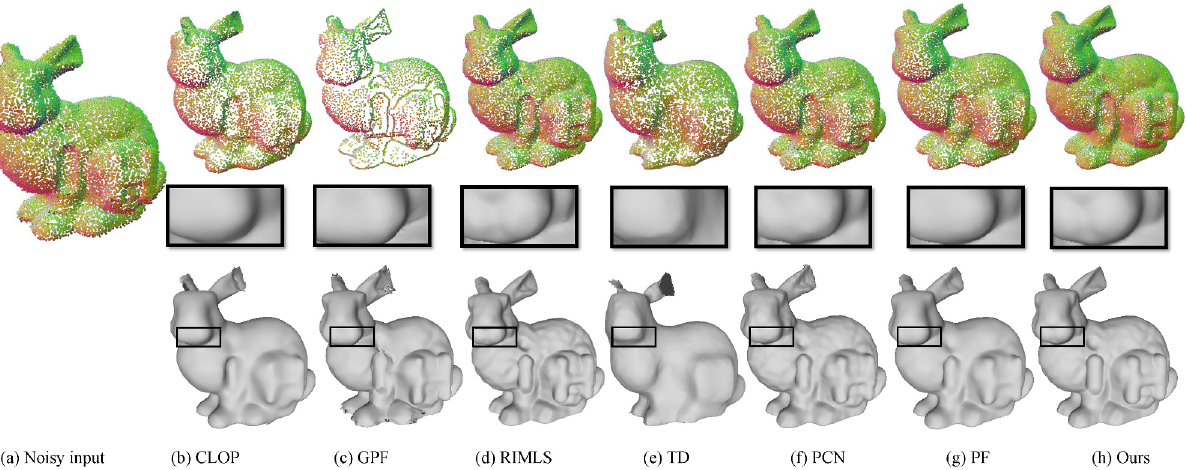
Fig. 4 Above: results on the Bunnyhi model corrupted with 0.5% synthetic noise. Below: surface reconstruction results.